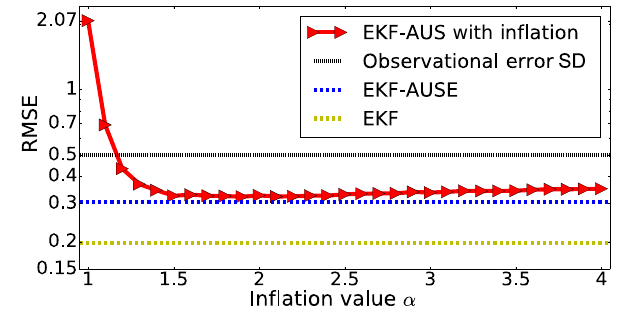
Figure 4. Analysis RMSE of EKF-AUS ( y axis), correction rank 17, with multiplicative inflation plotted versus the inflation value α ( x axis). Horizontal lines are the observation error standard devia- tion, EKF-AUSE and EKF analysis RMSE. Note the log scale of the y